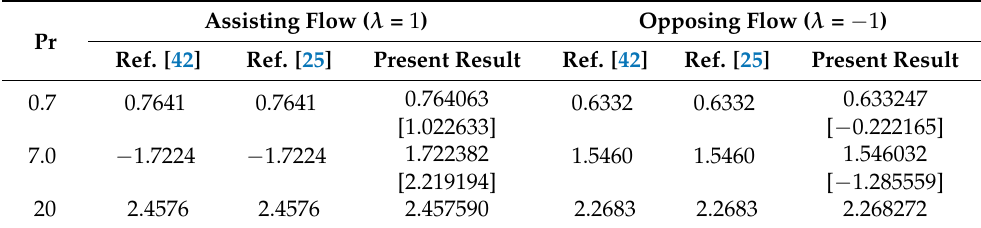
Table 4. Comparisons of − θ (cid:48) ( 0 ) when ϕ 1 = ϕ 2 = 0, s = 0, Q = 0.